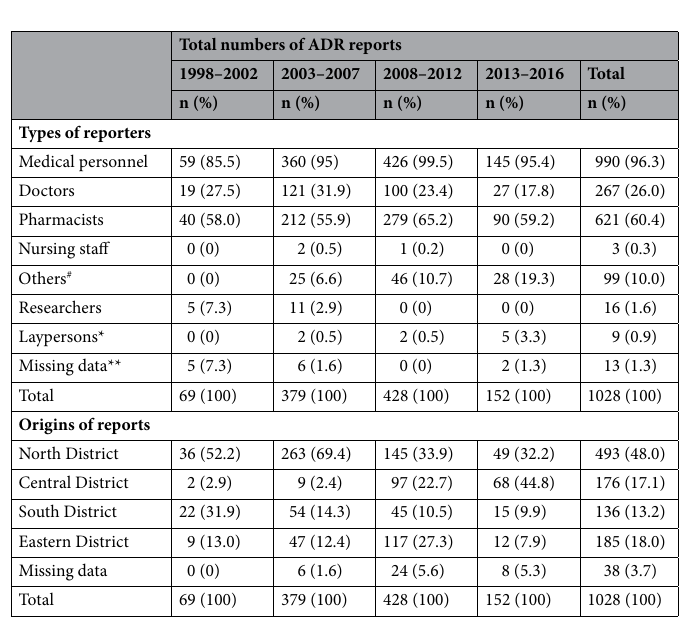
Table 2. 1028 ADR reports involving herbal medicines in the TADRRS-HM (1998–2016). TADRRS-HM Taiwan Adverse Drug Reaction Reporting System for Herbal Medicine. *Patients and caregivers. **Missing data refer to ADR records that were incompletely filled. # ADR records were filled by medical personnel, without attribution of the person’s professional